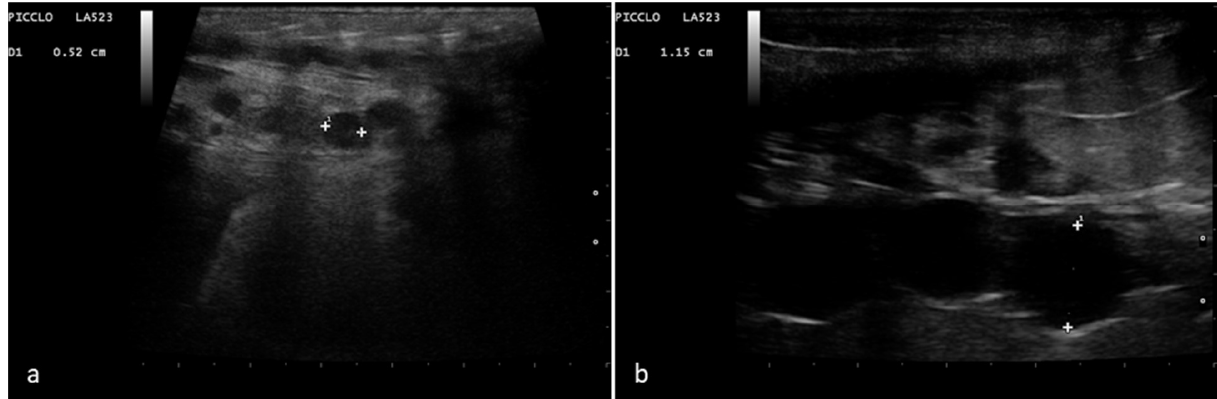
Figure 1. Rounded and aligned anechoic pre-ovulatory follicles of different sizes in a female Boa constrictor . Phase recognized in 100% of the subjects involved in the study. ( a ) Boa with 5 mm diameter follicles, before ovulation. ( b ) Boa with 11.5 mm diameter follicles, before ovulation.